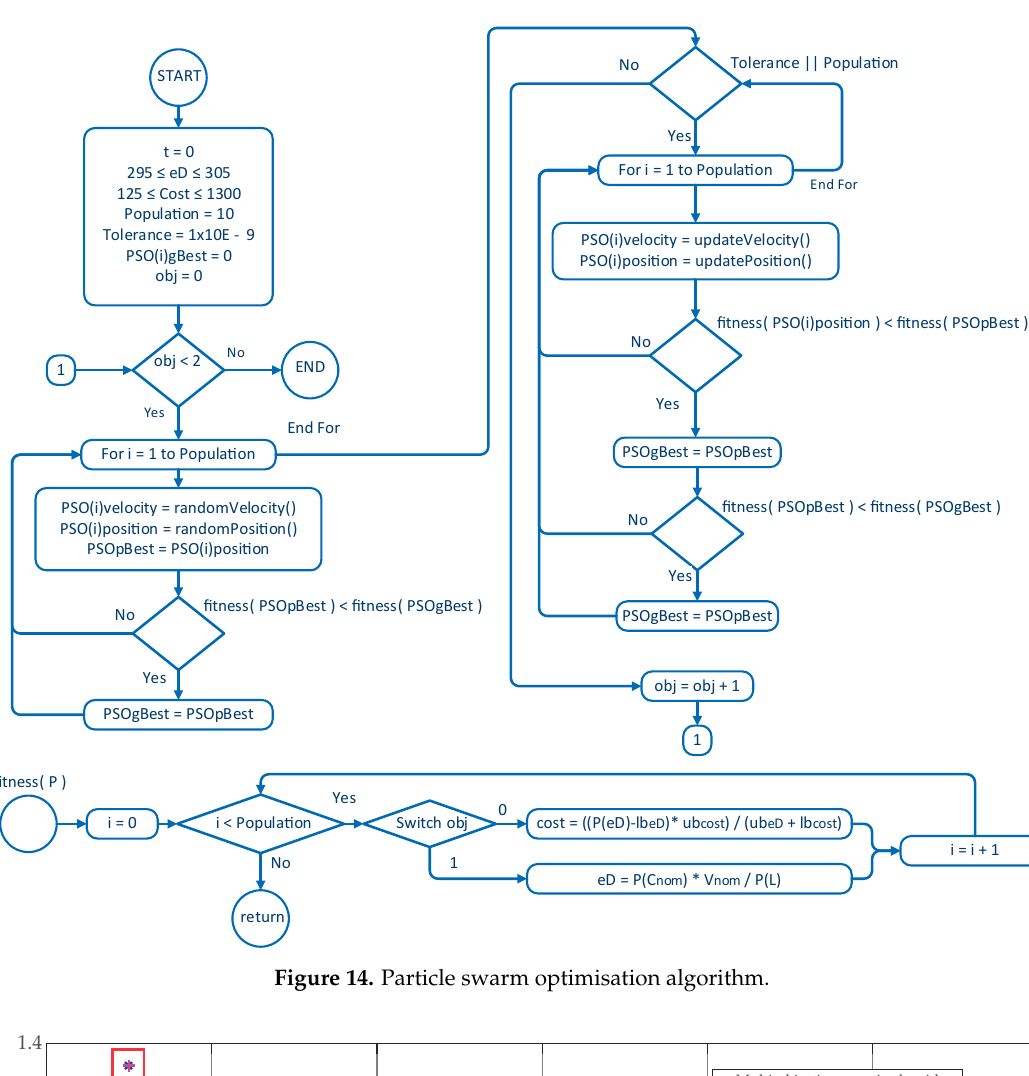
Figure 14. Particle swarm optimisation algorithm.